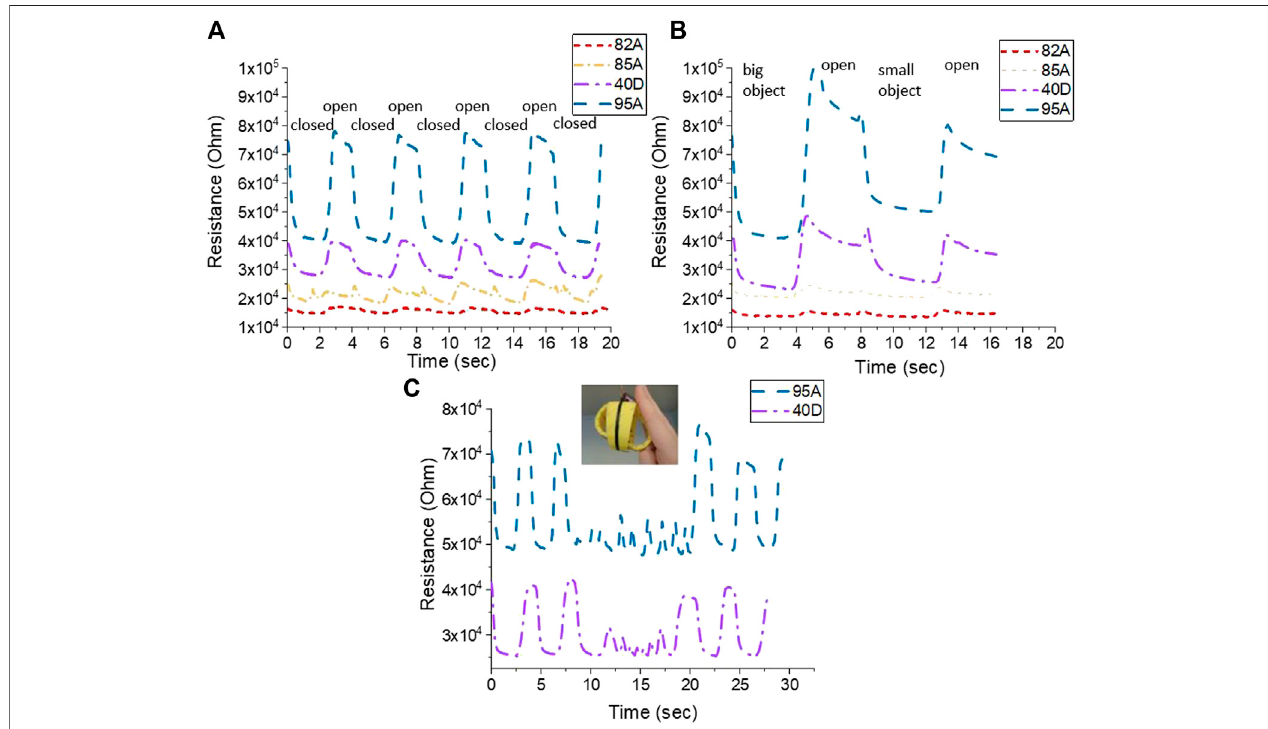
FIGURE9| Electricalsignalfromthe insitu printedsensingelementonthesoftrobotgripperstructures,usingdifferentTPU fi laments,when (A) cyclingbetweenthe openandclosedpositions, (B) grippingabigandasmallobject,and (C) duringmovingbetweentheopenandclosepositionswithandwithoutanobstaclepresent.The obstacle was imposed at the time point 10 s and lasted for about 10